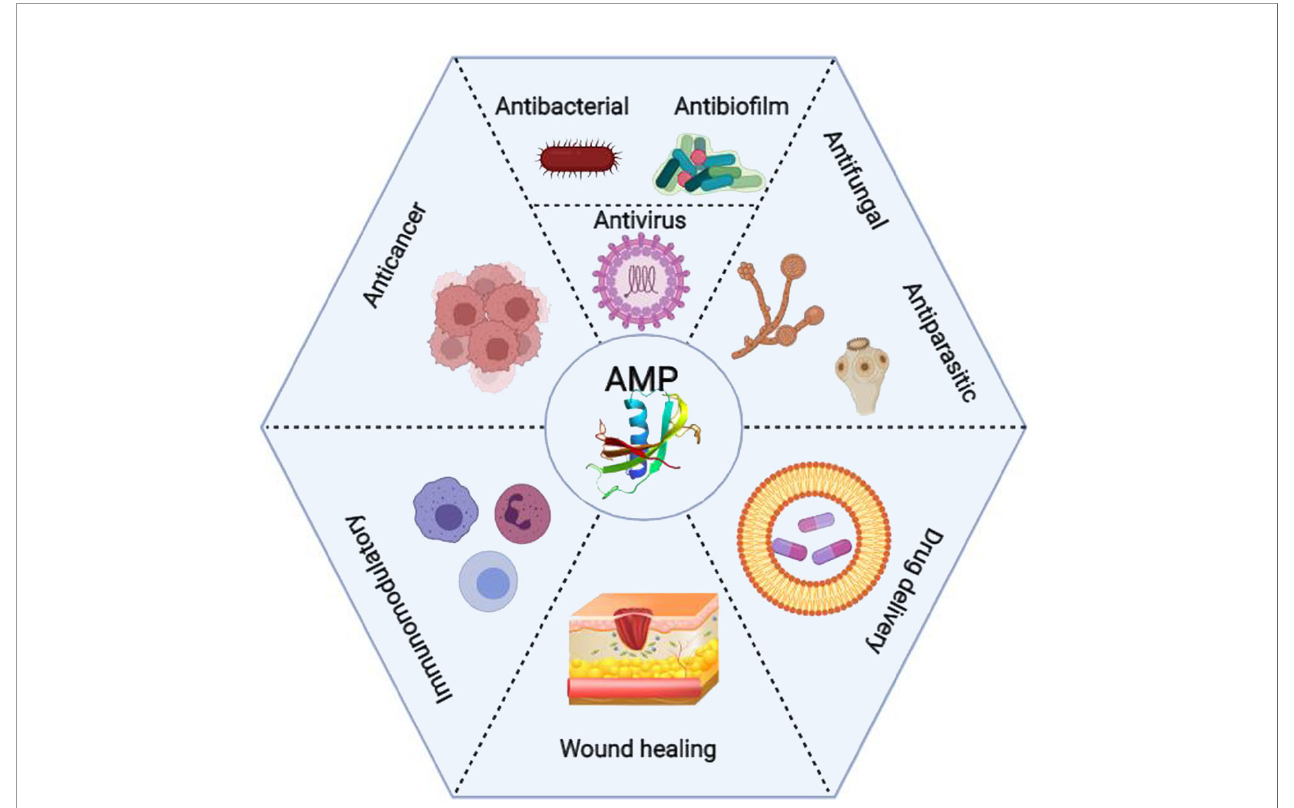
FIGURE 1 | Clinical applications of the antimicrobial peptides (AMPs) from wound healing and drug delivery to anticancer activity (Created with